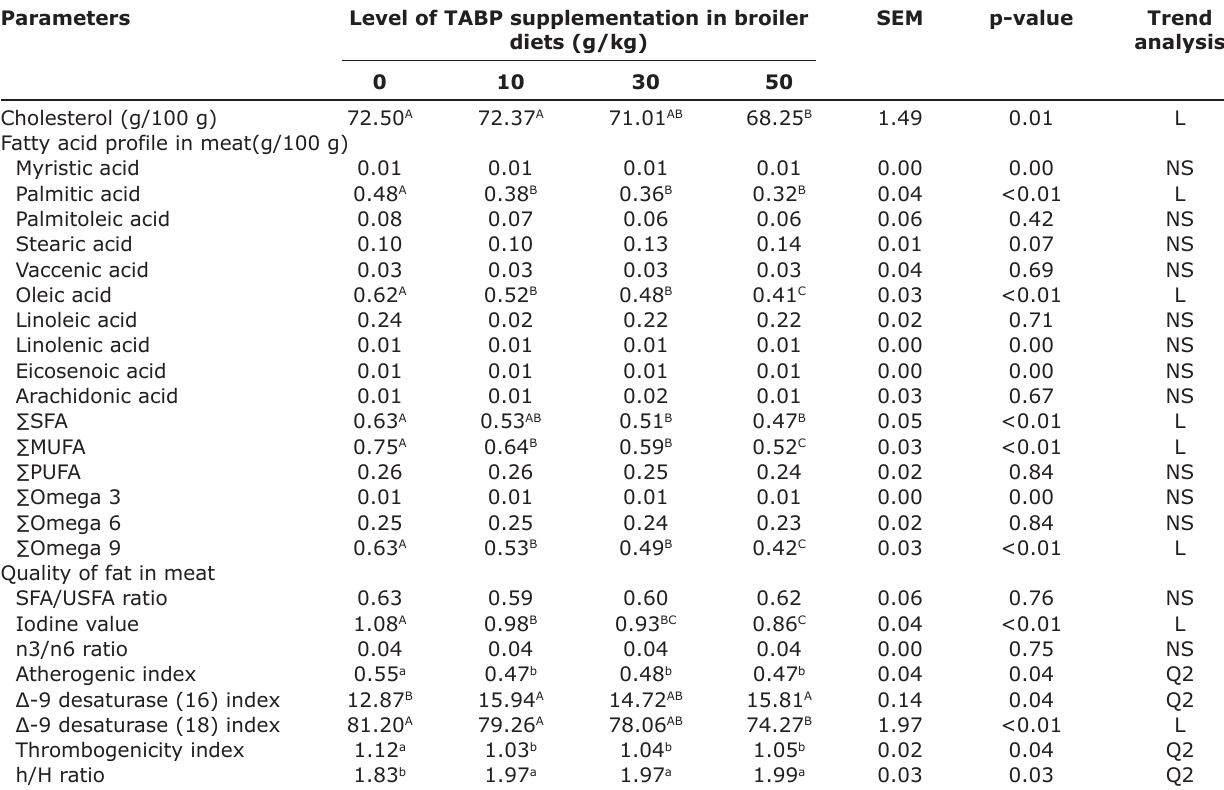
Table-8: Effects of TABP supplementation in broiler diets on fatty acid profile in meat.